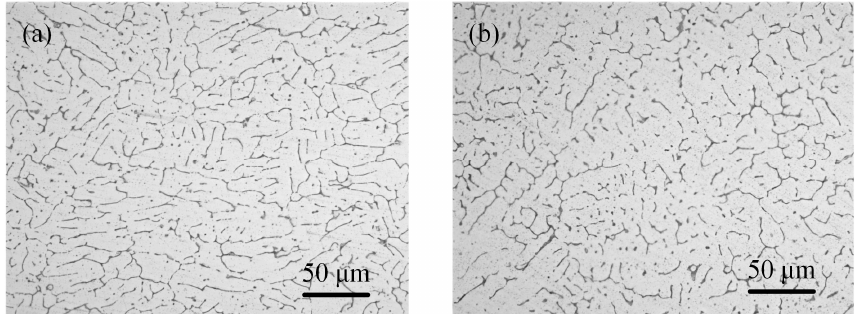
Figure 6. Microstructure at the center of the weld. ( a ) Laser-CMT hybrid weld; ( b ) plasma-CMT hybrid weld.